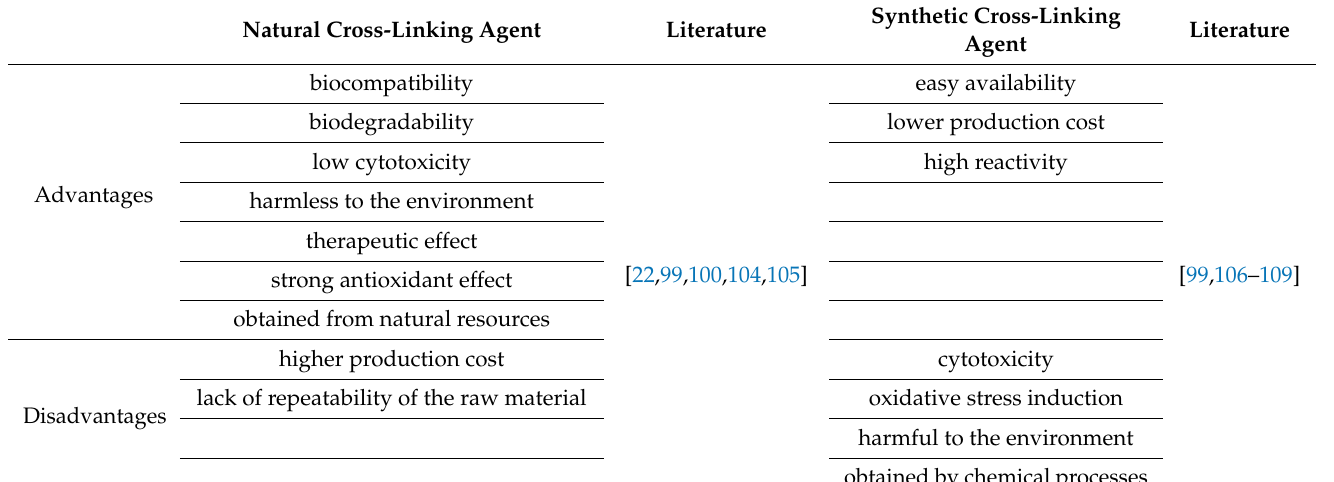
Table 1. Comparison of the properties of natural and synthetic cross-linking agents. Synthetic Cross-Linking Natural Cross-Linking Agent Literature